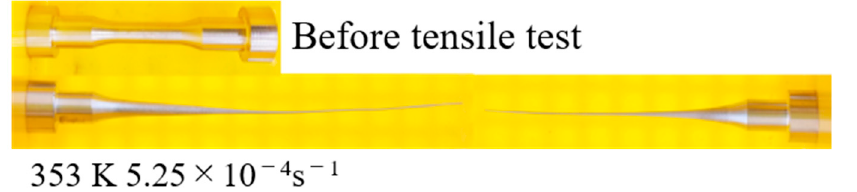
Figure 8. Photographs of Sn-40Bi-1.0Sb before and after the tensile testing at 353 K under a strain rate of 5.25 × 10 − 4 s − 1 .